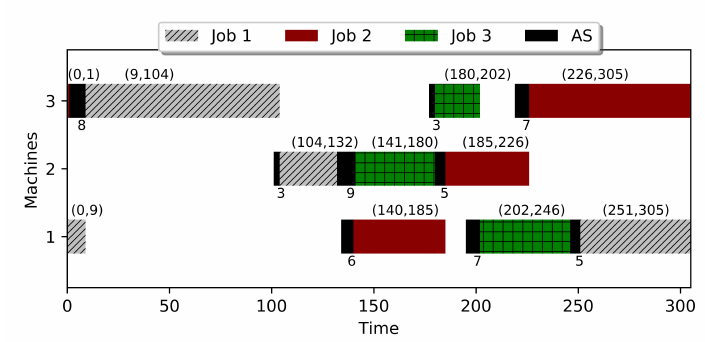
Figure 6. The detailed Gantt chart of the optimal solution found for the instance problem; blocking CJSS problem with sequence-dependent anticipatory setups (AS).